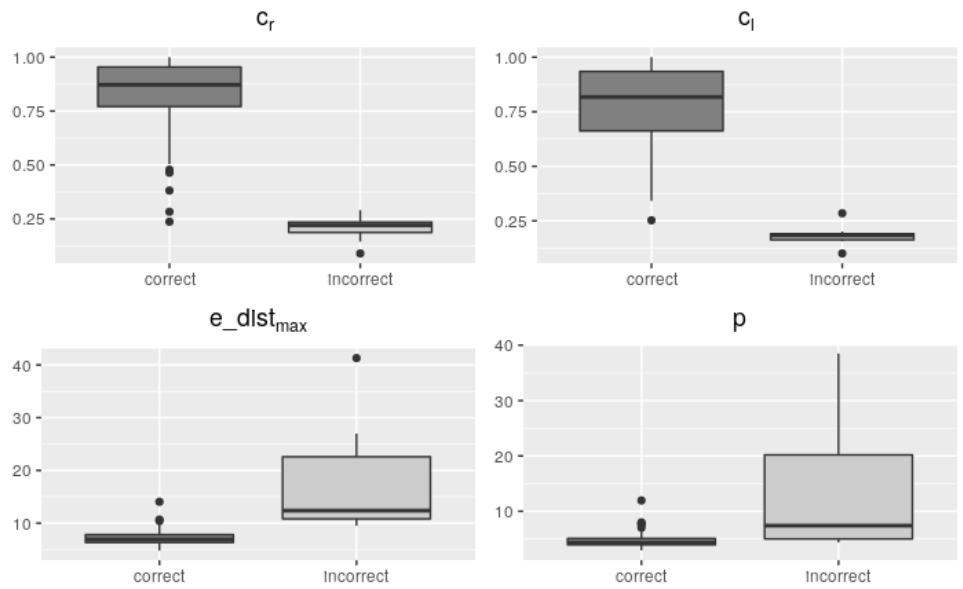
Figure A3. Boxplots of the parameter values against detection results.